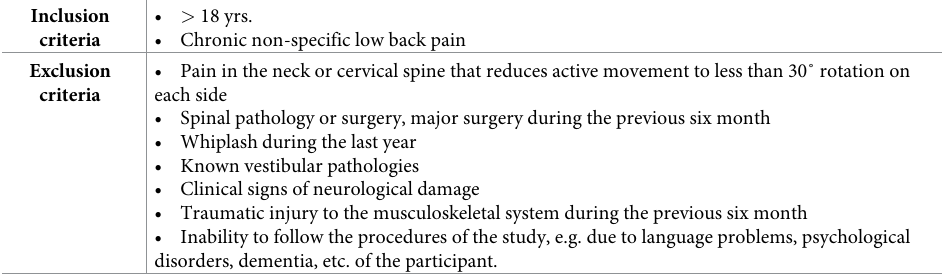
Table 1. Criteria for inclusion and